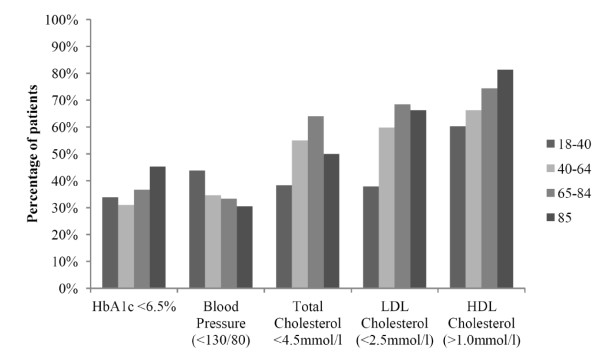
Achievement of outcomes by age category.